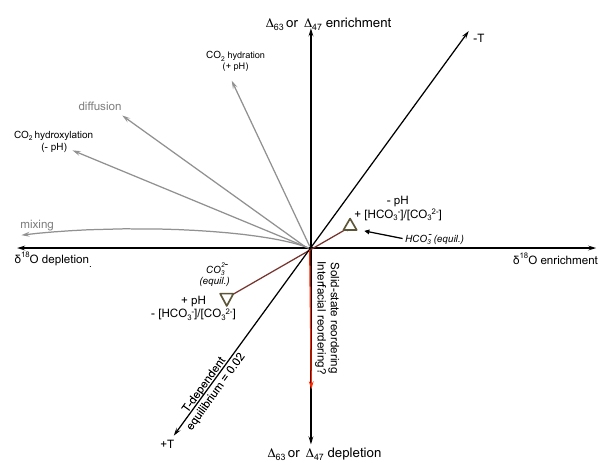
Figure 10. Schematic illustrating general trajectories for different processes on stable isotope signatures ( (cid:49) 63 or (cid:49) 47 values and δ 18 O), relative to an arbitrary point. Equilibrium temperature de- pendence is shown (Ghosh et al., 2006). Note that mixing of DIC from different sources results in curved trajectories (in δ 18 O space, mixing is linear, whereas in (cid:49) 47 space can be nonlinear) (Eiler and Schauble, 2004; Thiagarajan et al., 2011; Defliese and Lohmann, 2015). Diffusion results in enrichment of clumped species and de- pletion in δ 18 O (Thiagarajan et al., 2011). CO 2 hydration reac- tions are strongly temperature pH-dependent and also result in en- richment of clumped species and depletion in δ 18 O (Affek, 2013; Tang et al., 2014; Tripati et al., 2015). At any given temperature, equilibrium DIC species have differing clumped and oxygen iso- tope signatures, potentially also giving rise to pH effect (Hill et al., 2014; Tripati et al., 2015). Solid-state diffusion processes (Passey and Henkes, 2012; Henkes et al., 2014), including hypothesized re- ordering in the interfacial region (Tripati et al., 2015) only influence clumped isotope signatures and not bulk isotopic signatures (e.g., δ 18 O).